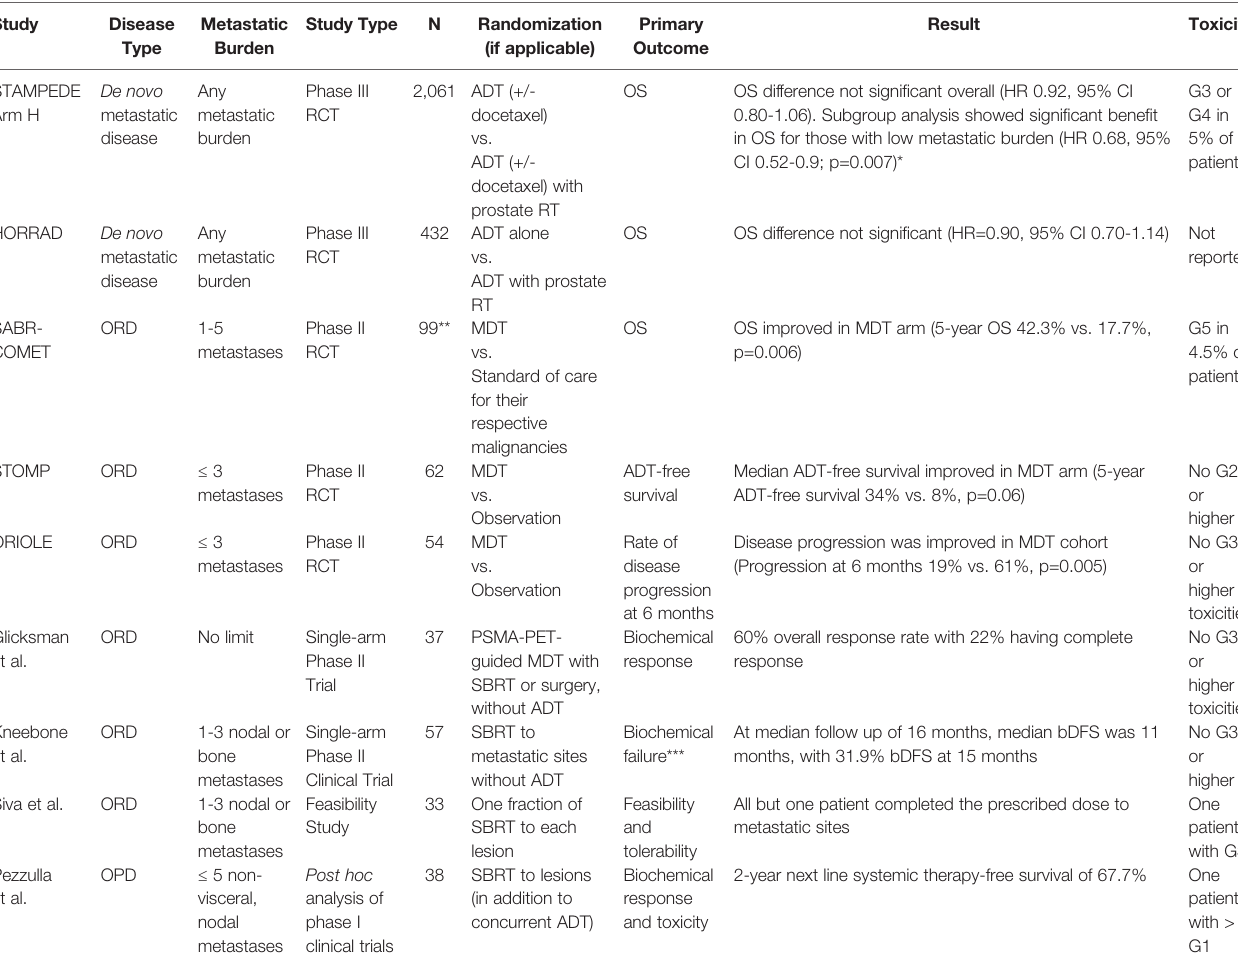
TABLE 1 | Prospective trials evaluating the role of radiotherapy in (oligo)metastatic prostate